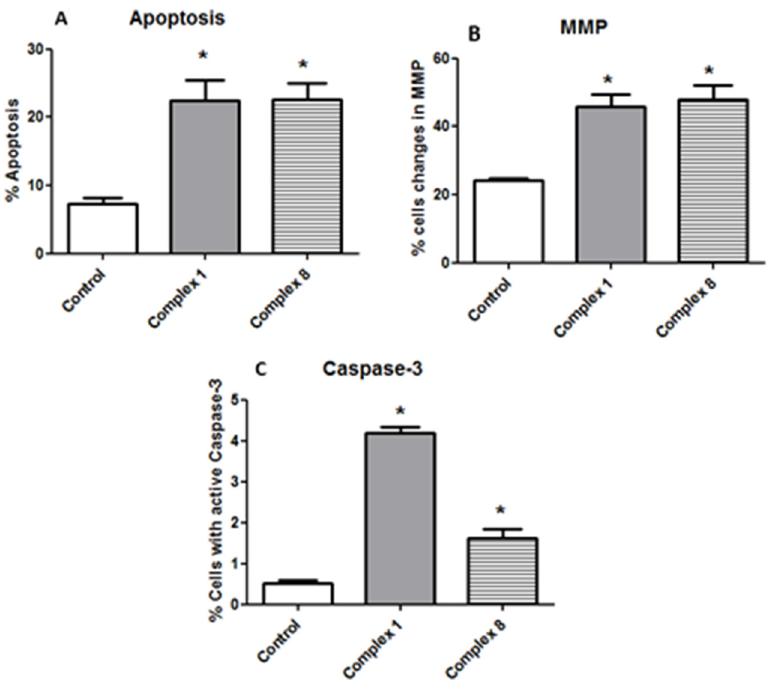
Figure 3. Caco-2 cell death studies by flow cytometry after incubation with complexes 1 (1.14 µM) and 8 (7.22 µM) for 48 and 72 h, respectively. ( A ) The results of the apoptotic state are expressed as a percentage. ( B ) The percentage of Caco-2 cells with disturbed mitochondrial membrane potential (MMP). ( C ) The percentage of Caco-2 cells with the presence of active caspase-3. * p < 0.05 compared to the respective control.